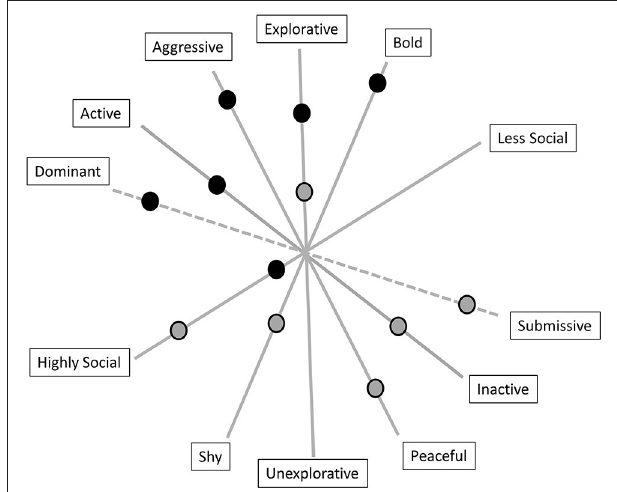
FIGURE 2 | The five basic factors in animal personality research (bold lines) that can also be used to describe coping style. The dominance factor is presented in dashed lines because there are insufficient data to consider it as a fully accepted sixth factor in animal personality. The dots represent two imaginary animals with different coping styles. The animal behaving as described by the black-gray dots would represent a reactive coper, while the animal behaving as described by the black dots would be considered as a proactive individual. Intermediate individuals would express behavior described by a mixture of scores on the factors resulting in individual differences along a